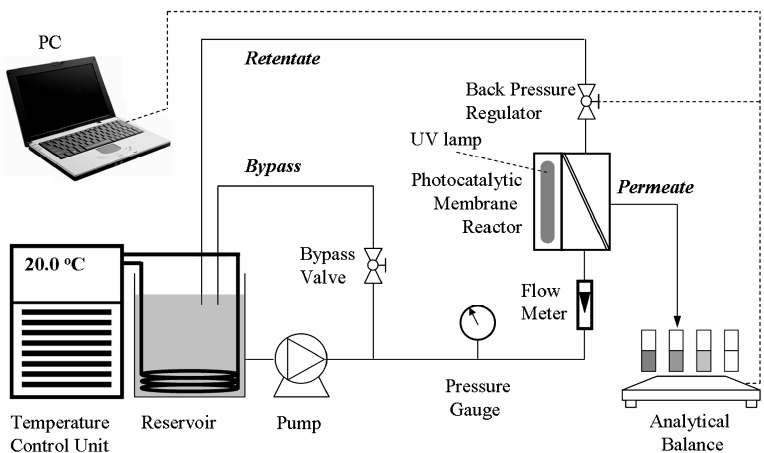
Figure 5. Schematic diagram of a lab scale PMR operated in cross flow mode with only the retentate returned back into the feed tank. Adapted with permission from [60], Copyright Elsevier, 2010.